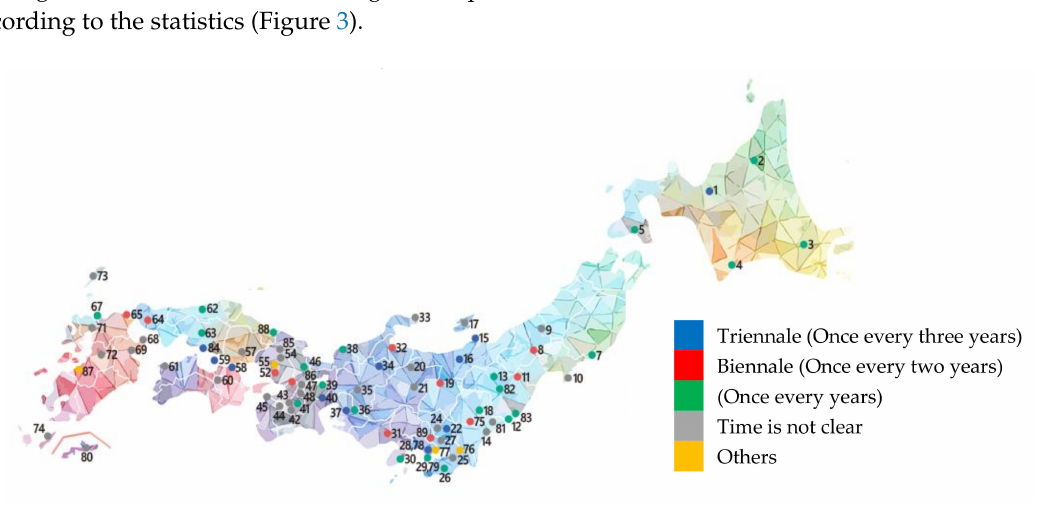
Figure 2. A map of Japanese Art Festivals.